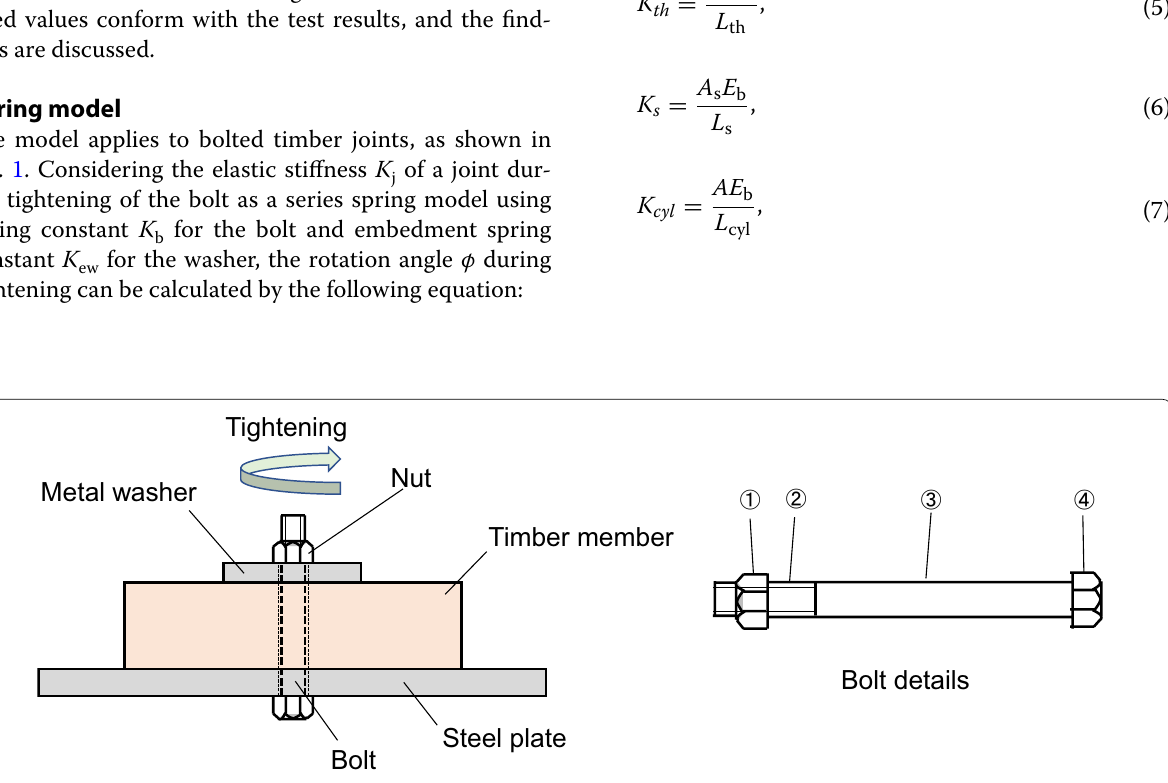
Fig. 1 Bolted timber joints and bolt